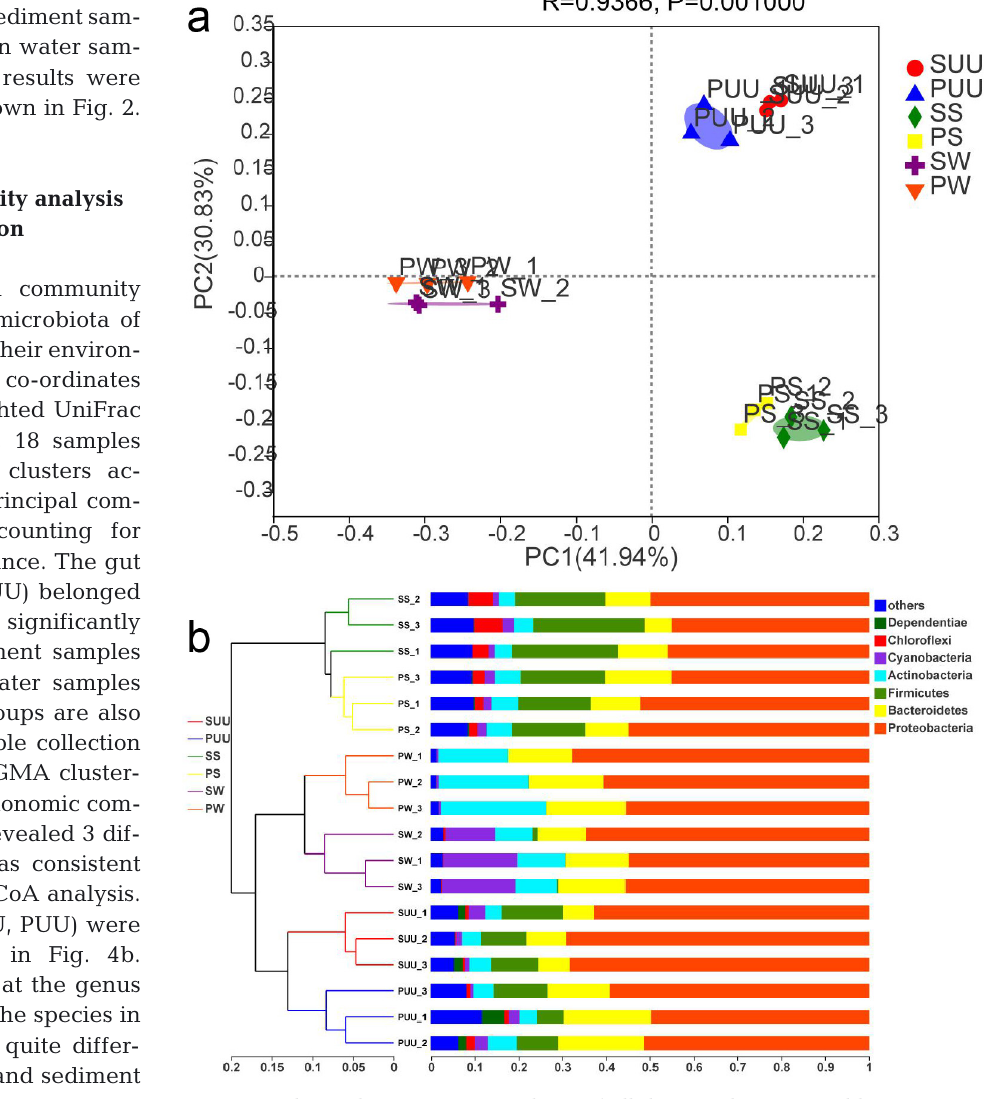
Fig. 4. Relationships among microbiota of all the samples (group abbrevia- tions as in Table 1). (a) Principal coordinates analysis (PCoA) showing the separate distribution of gut microbiota composition between sediment groups and seawater groups. The PC1 and PC2 axes explain 41.94 and 30.83% of the variation, respectively. Differences in community composition between samples from different groups were examined using ANOSIM, with 999 replacements. (b) UPGMA clustering tree at the phylum level among different